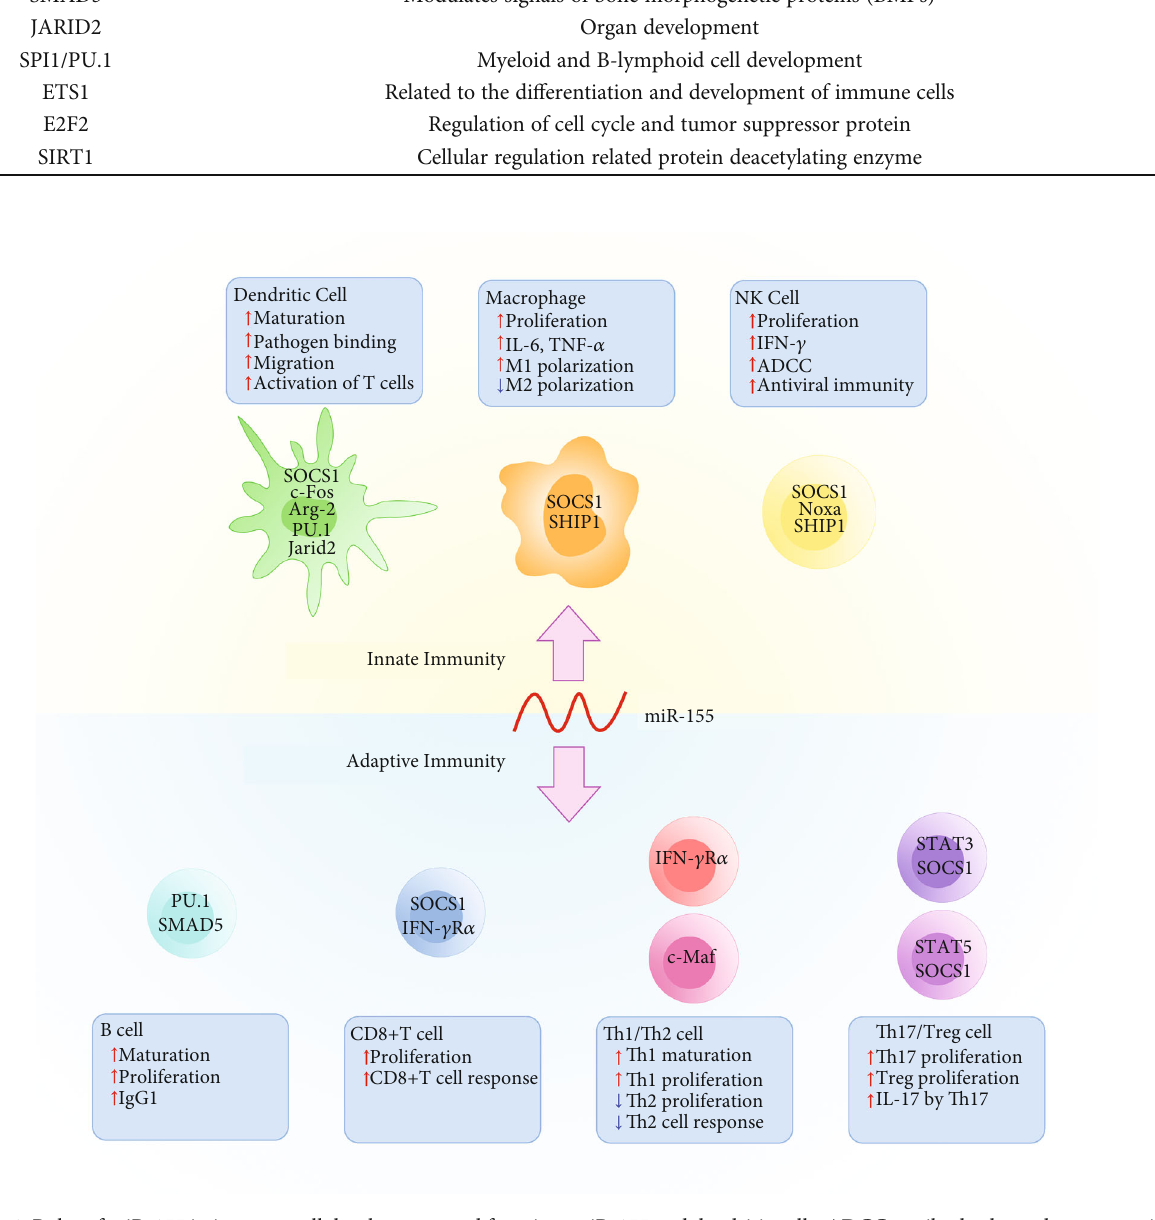
Figure 1: Roles of miR-155 in immune cell development and function. miR-155 and dendritic cells. ADCC: antibody-dependent cytotoxicity; Th1: T helper 1; Th2: T helper 2; Th17: T helper 17; Treg: regulatory